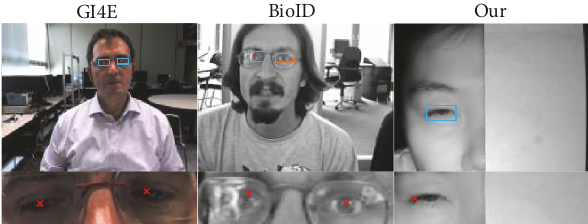
Figure 10: Some samples from the BioID, GI4E, and our datasets in which the proposed method fails in the eye classification and eye center